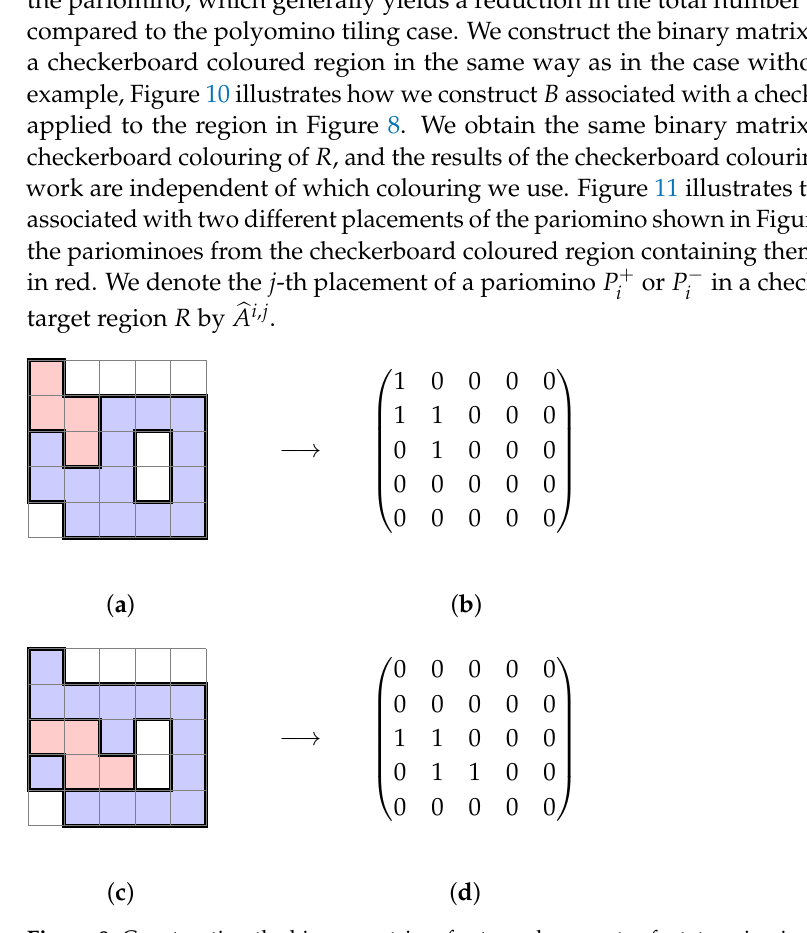
Figure 9. Constructing the binary matrices for two placements of a tetromino in R : ( a ) first placement of P 1 ; ( b ) binary matrix A 1,1 ; ( c ) second placement of P 1 ; ( d ) binary matrix A 1,2 .